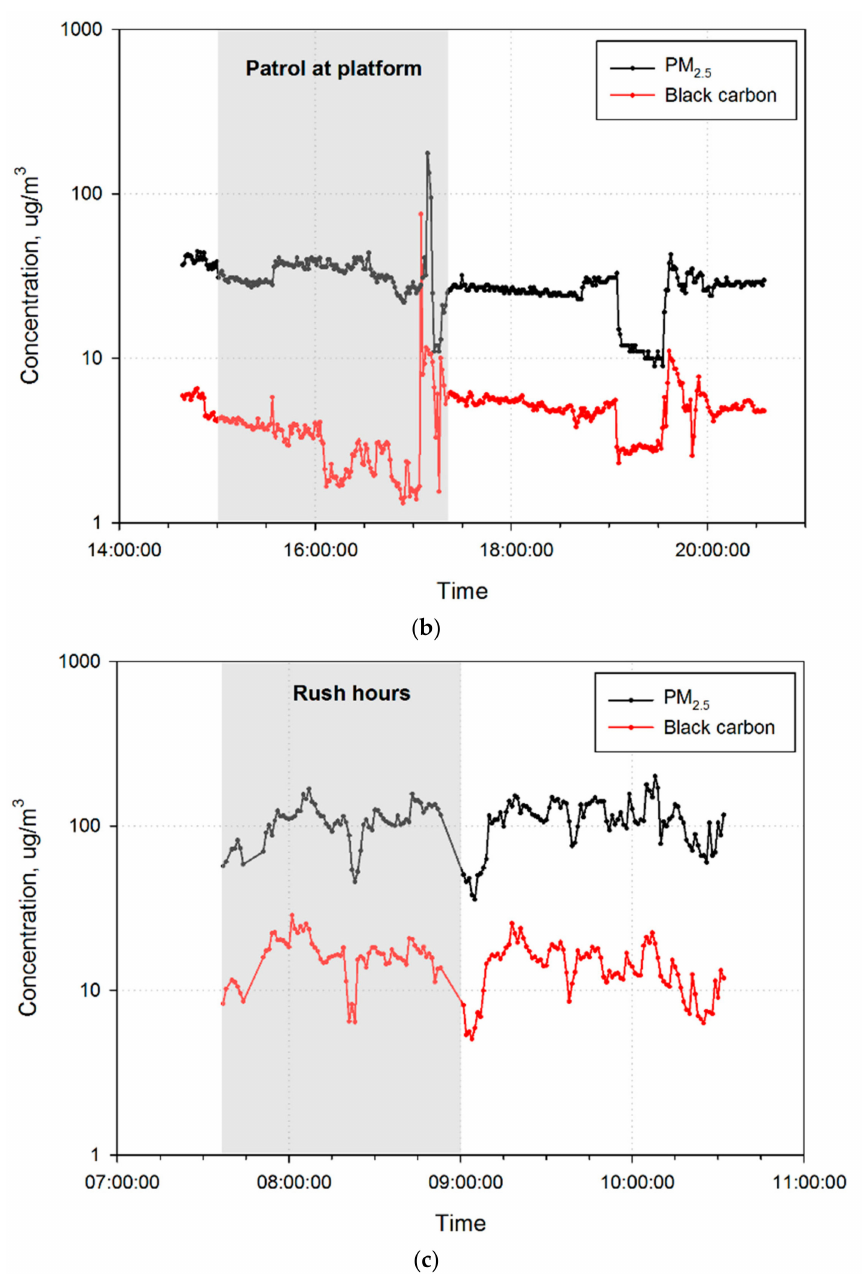
Figure 3. Real-time patterns of exposure to PM 2.5 and BC according to job. ( a ) Maintenance engineers; ( b ) subway station managers; ( c ) train